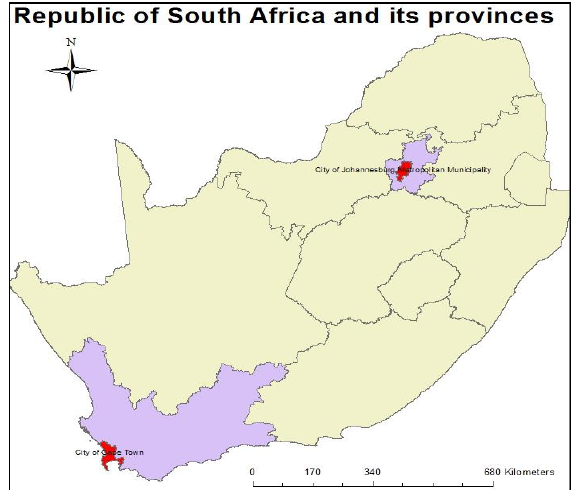
Figure 1: Map of South Africa showing the 2